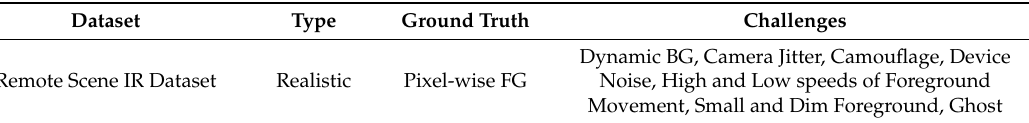
Table 3. Introduction of the Remote Scene IR dataset. Table 4. Introduction of the Remote Scene IR